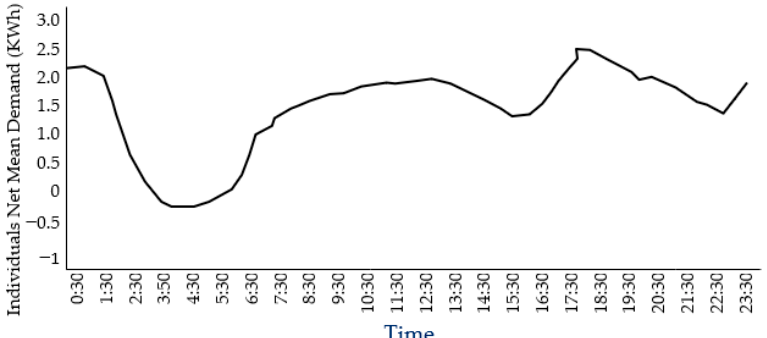
Figure 6. Tested Sample Weighted index trend chart.